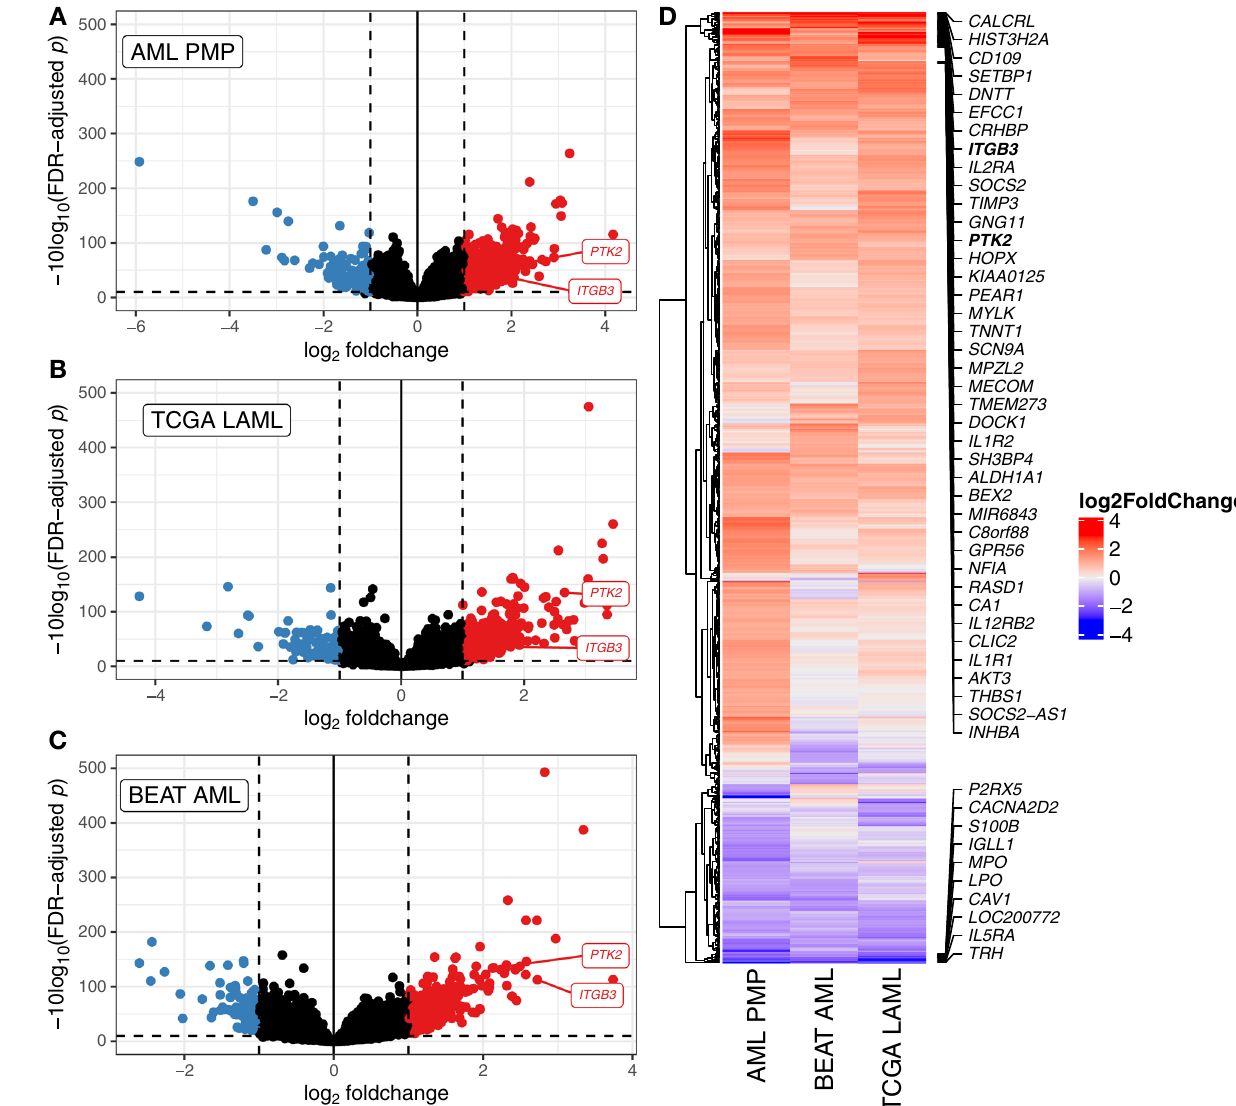
Fig. 7 Differential gene expression for patients with fi rst-tercile vs. third-tercile APS values. A – C Volcano plots of differentially expressed genes for the AML PMP ( A ), TCGA LAML ( B ), and Beat AML ( C ) cohorts. Genes with absolute log 2 fold-change of 1 and FDR-adjusted p ≤ 0.1 (based on Wald tests as implemented in DESeq2) are highlighted in red (over-expressed in third-tercile APS) and blue (over-expressed in fi rst-tercile APS). D Comparison of differentially expressed genes between cohorts. All genes which were differentially expressed in any single cohort are displayed with their log2FoldChange values across all cohorts. The top 40 over-expressed and bottom ten under-expressed genes (by mean fold-change across cohorts) are